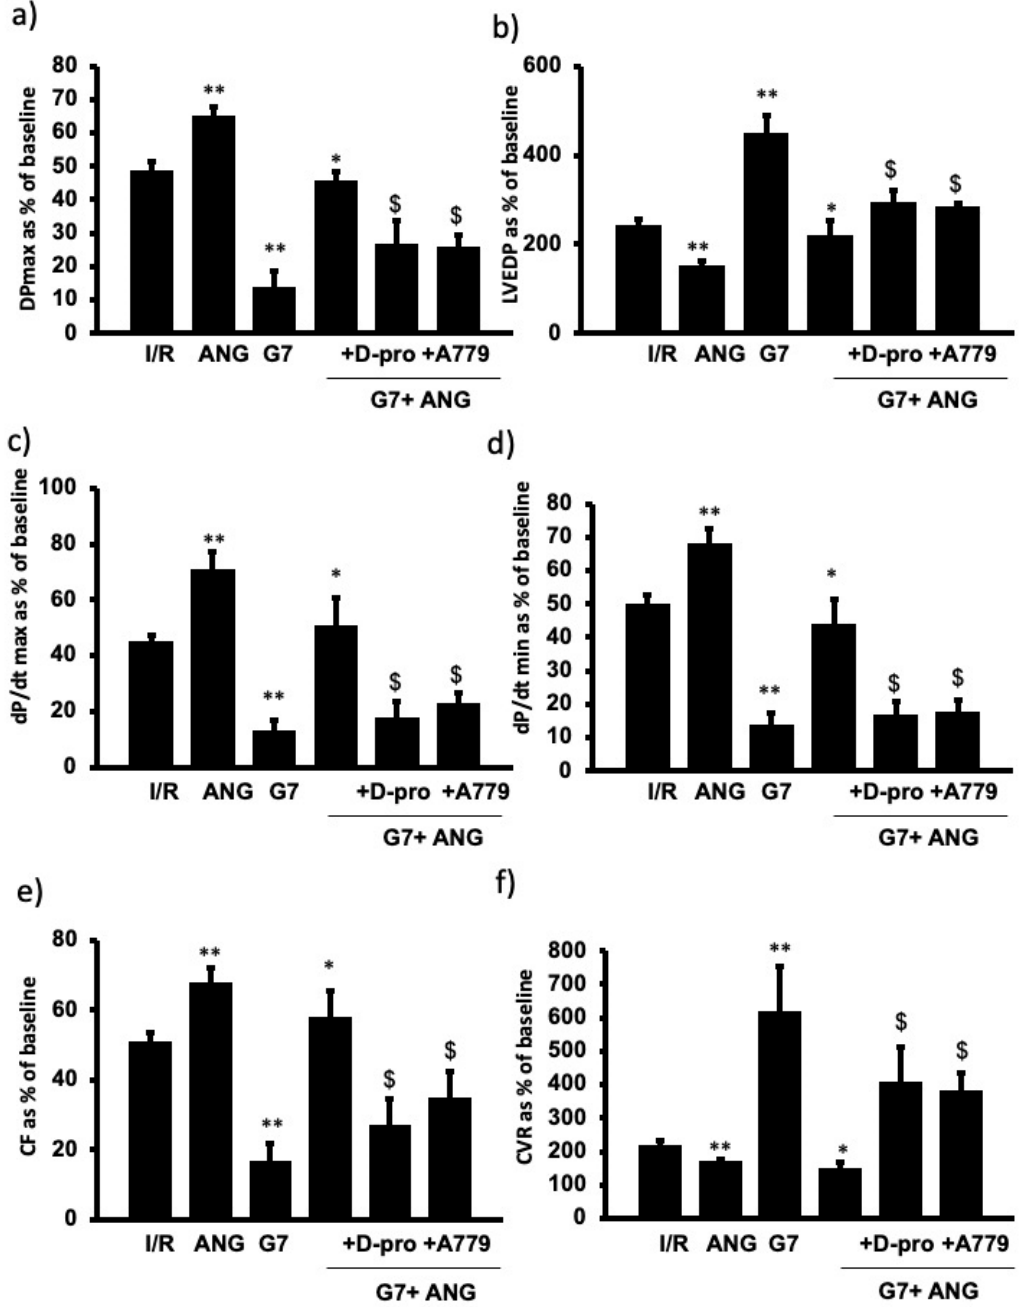
Figure 4. Ang-(1-7) via its Mas Receptor rescues cationic G7 PAMAM-induced impairment of cardiac function ( a – f ). Post I/R recovery in the left ventricle function (DPmax ( a ) and LVEDP ( b )), contractility indices (+dP/dt ( c ) and − dP/dt ( d )) and coronary vascular dynamics (CF ( e ) and CVR ( f )) after treatment with G7 PAMAM in presence or absence of Ang-(1-7) and its Mas receptor blockers D-Pro and A779. The data were computed after 30 min reperfusion and expressed as the mean ± SEM. DPmax: maximum developed pressure; LVEDP: left ventricular end-diastolic pressure; CF: coronary flow; CVR: coronary vascular resistance; Ang-(1-7): angiotensin-91-7); D-Pro: Ang-(1-7) selective antagonist; A779: Ang-(1-7) selective antagonist (see Section 2). Double Asterix ** refers to significant difference ( p < 0.05) compared to control I/R alone and single Asterix * refers to significant difference ( p < 0.05) compared G7 values. Dollar sign ($) indicates significant difference ( p < 0.05) compared to G7 +